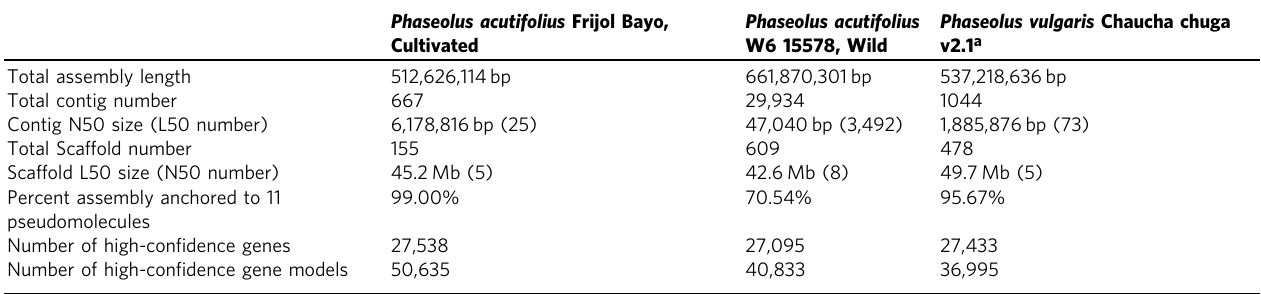
Table 1 Genome assembly and annotation metrics of Phaseolus